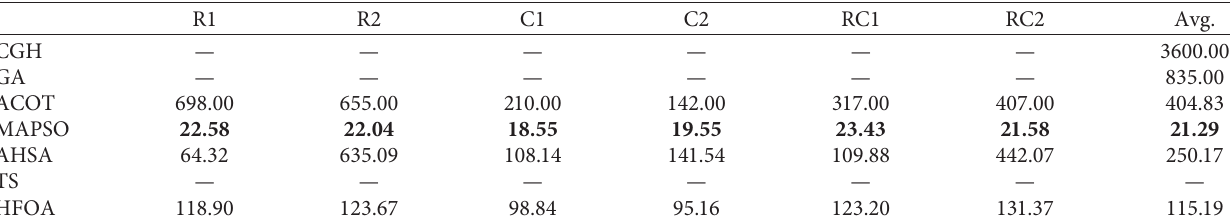
Table 7: The computational time (average) of the state-of-the-art methods. R1